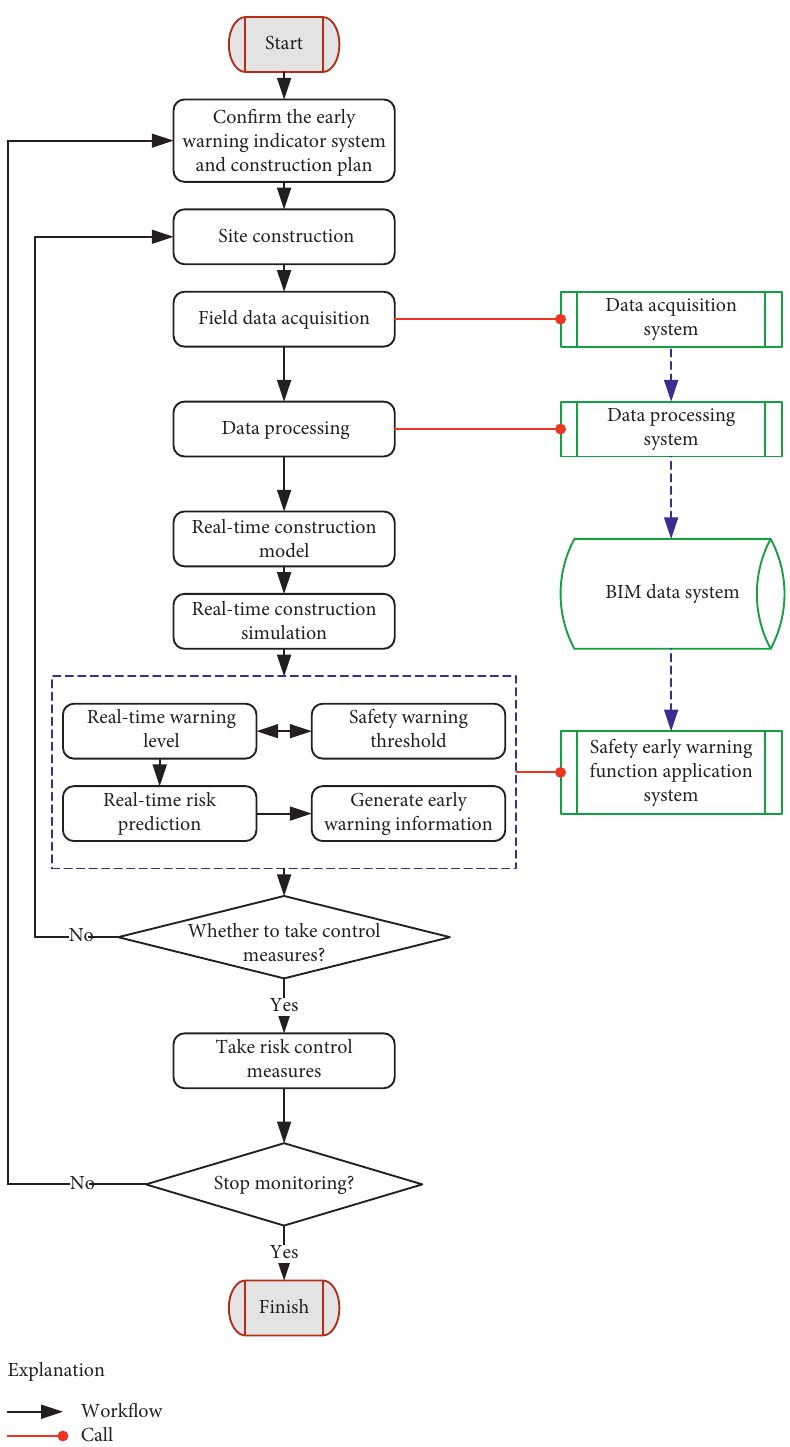
Figure 4: Running process of real-time security early warning